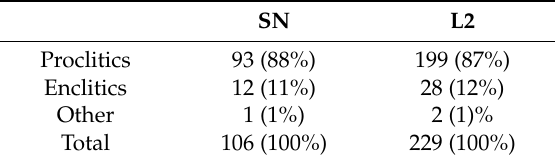
Table 3. Proclitics vs. enclitics.